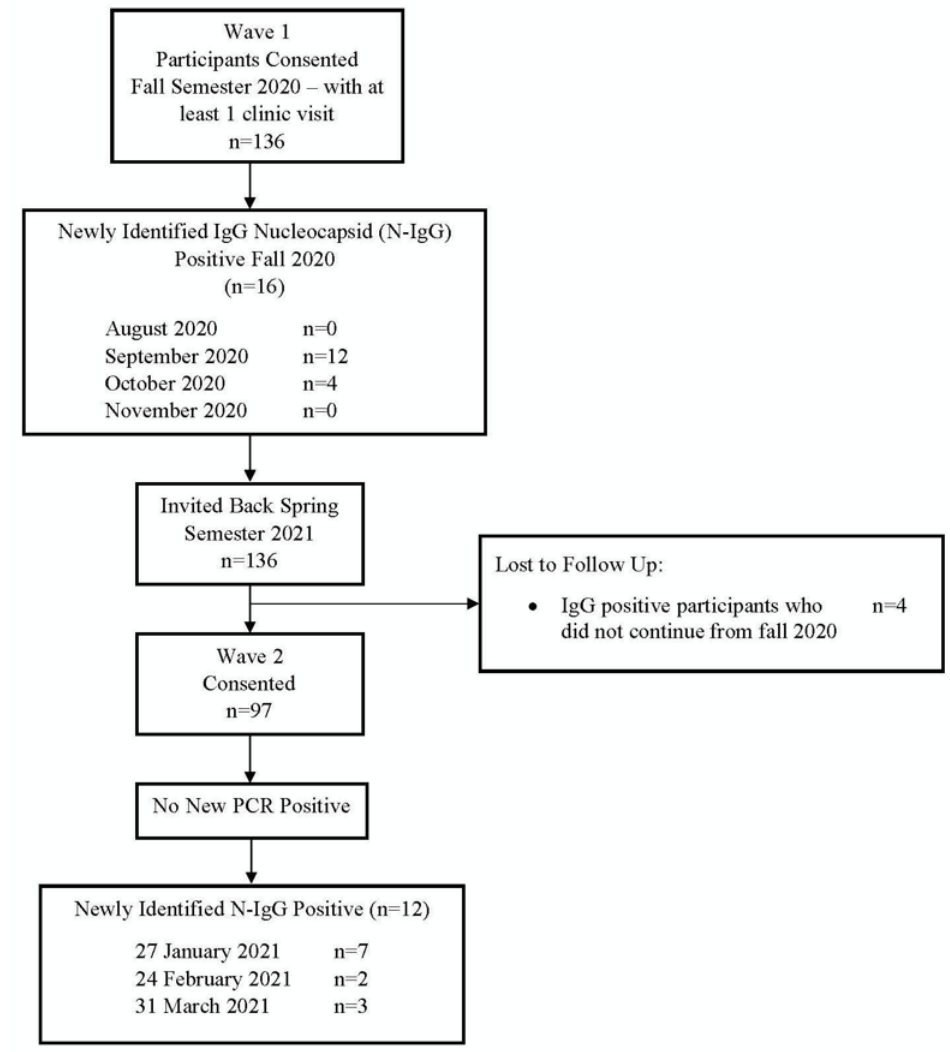
Figure 1. Participant flow between fall 2020 and spring 2021.